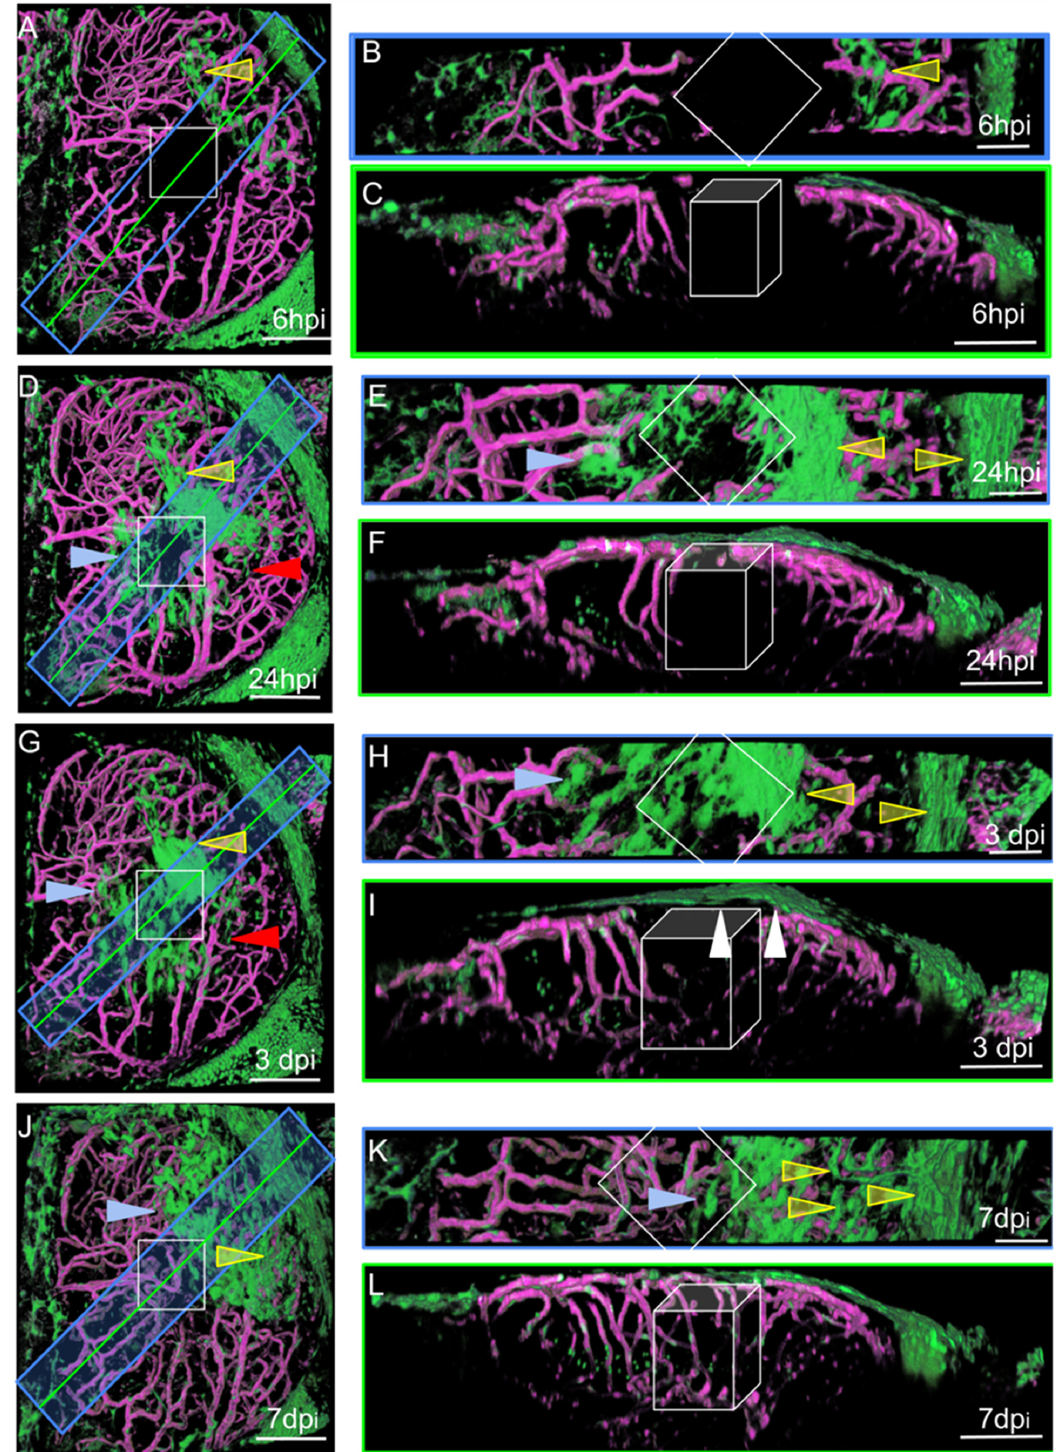
Figure 4. Surface laser injury of the optic tectum (OT) at 21 dpf. ( A , D , G , J ). Dorsal views. Blue rectangles: locations of horizontal sections in the right panels. Yellow lines: locations of XZ sections in the right panels. Anterior at the top. Midline on the left. ( B , E , H , K ) Horizontal thick sections. ( C , F , I , L ) XZ sections. ( I ). At 3 dpi, multiple layers of arachnoid cells are visible over the wound (white arrowheads). Putative injured zones: white squares and boxes. ARA-like cells: yellow arrow- heads. MID-like cells: blue arrowheads. Fibroblast-like cells: red arrows. Scale bars: ( A – L ): 100 µ m. ( B , E , H , K ): 50 µ